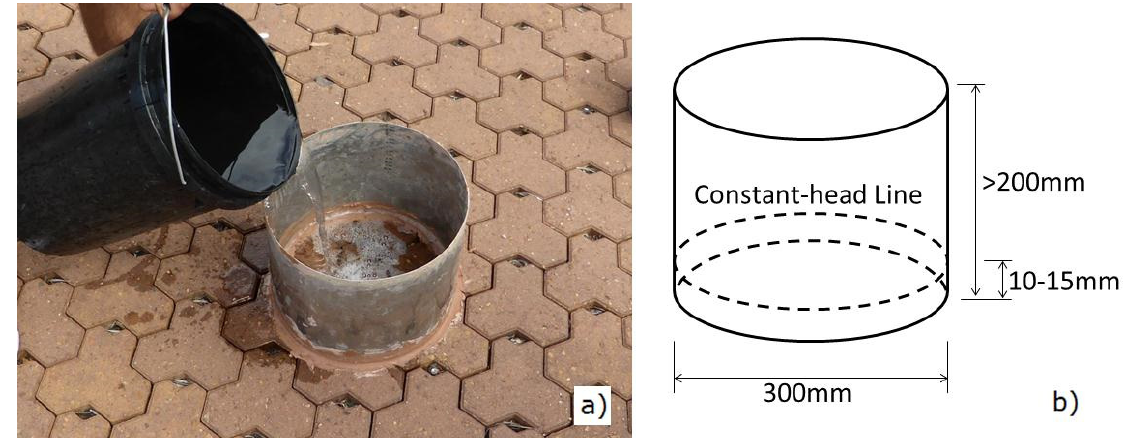
Figure 2. Single-Ring Infiltrometer Test (SRIT) used in this study. ( a ) SRIT during operation; ( b ) SRIT ring